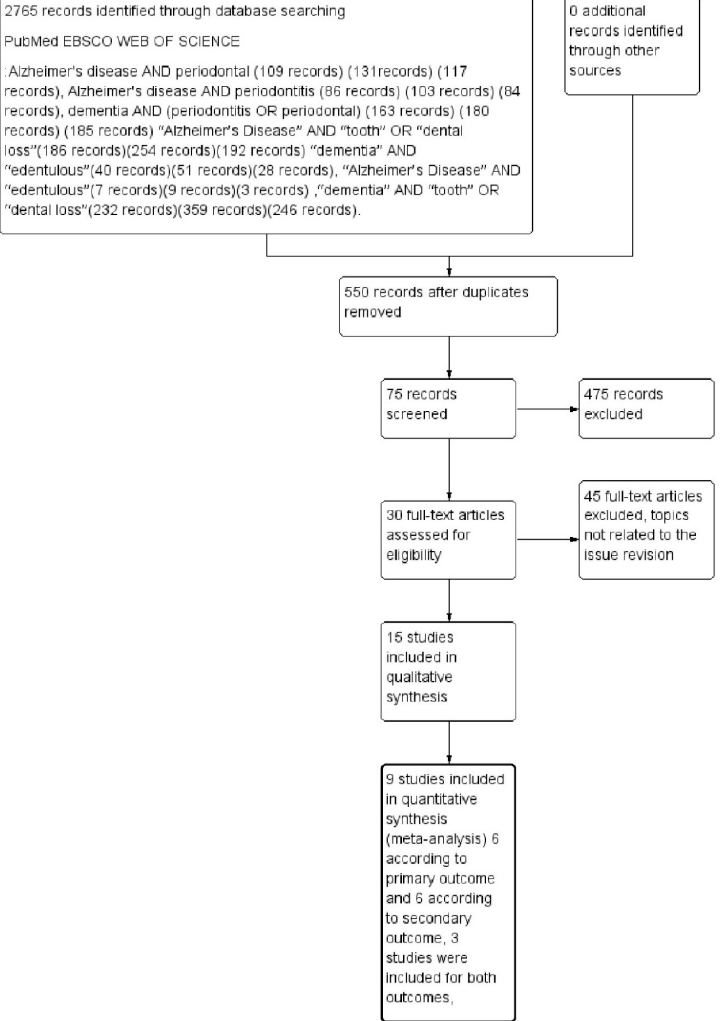
Figure 1. Flowchart describing research methodology, following the PRISMA protocol guidelines.